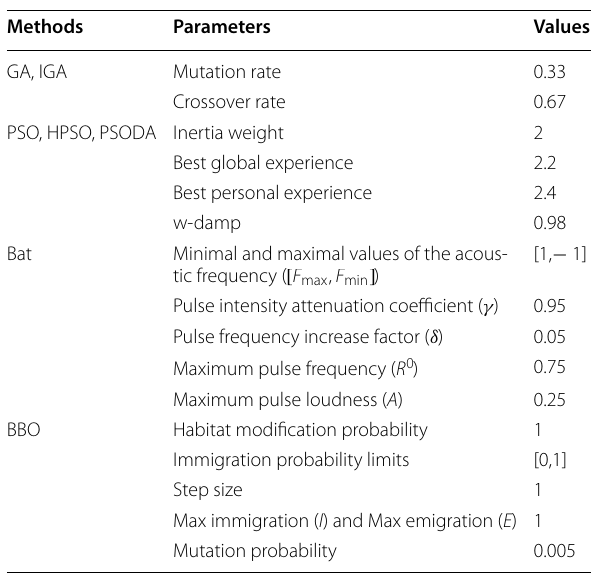
Table 1 Parameter